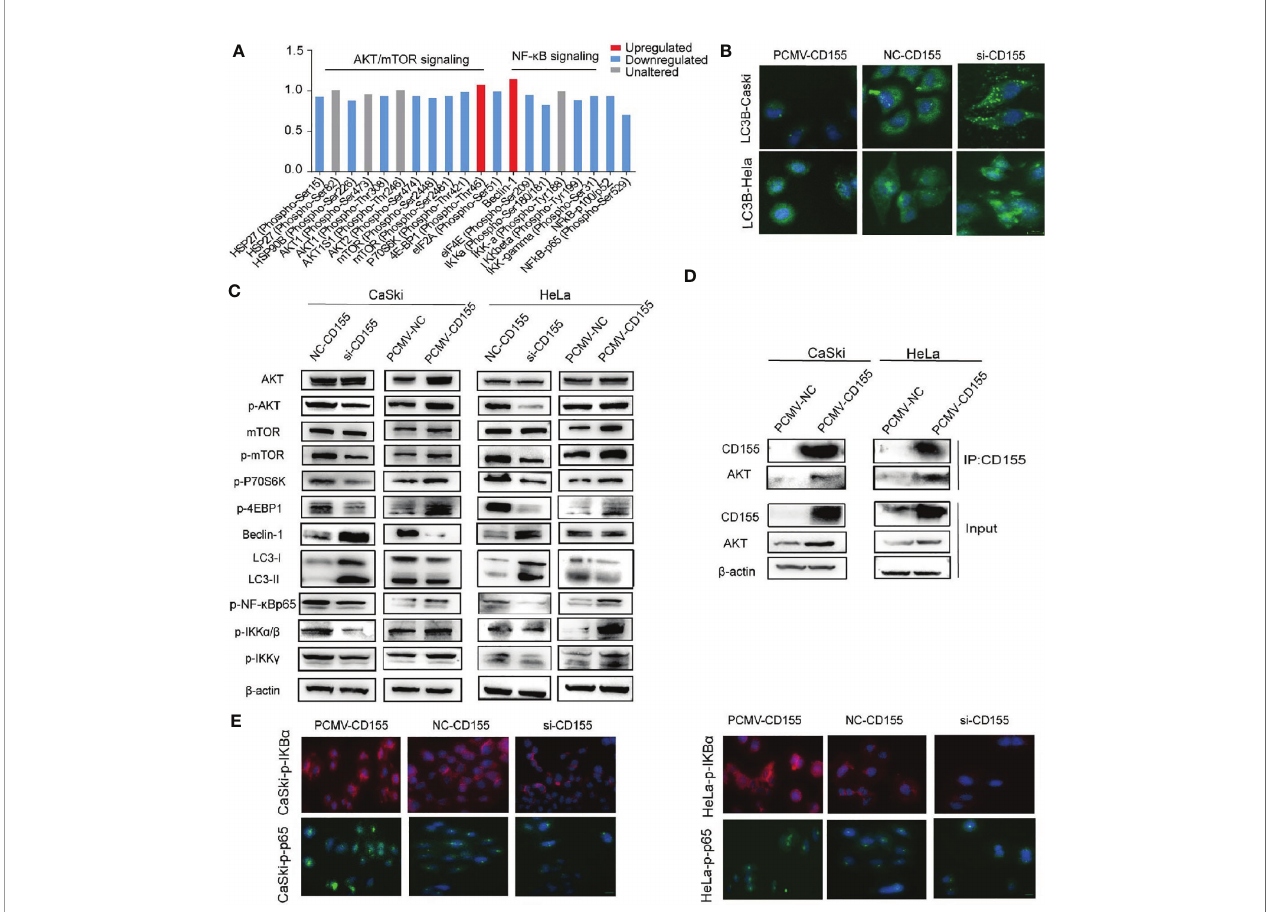
FIGURE 4 | CD155 regulates the AKT/mTOR pathway, autophagy, and the NF- k B (NF- k B) pathway. (A) Phosphoproteome array analysis of phosphoprotein expression changes after CD155 knockdown in CaSki cells. Phosphoproteins whose levels increased or decreased by more than 12% are marked in red and blue, respectively. (B) Immuno fl uorescence staining of LC3B in CaSki and HeLa cells transfected with CD155 siRNA (si-CD155), negative control RNA (NC-CD155), or PCMV-CD155, Scale bar: 10 µm. (C) Western blot analysis of the protein levels of AKT, p-AKT, mTOR, p-mTOR, p-4EBP1, p-p70S6K, Beclin1, LC3I, LC3II, p-NF- k Bp65, p-IKK a / b , and p-IKK g in CaSki and HeLa cells transfected with NC-CD155, si-CD155, PCMV-NC, or PCMV-CD155. b -actin was used as a loading control. (D) The Co-IP results showed that CD155 interacted with AKT to form the CD155/AKT complex. The Co-IP and western blot results showed that in PCMV-CD155 CaSki and PCMV-CD155 HeLa cells, the abundance of the CD155/AKT complex was signi fi cantly increased. (E) Immuno fl uorescence for p-NF- k Bp65, p-IKB a using CaSki and HeLa cells infected with CD155 siRNA (si-CD155), negative control RNA (NC-CD155), or PCMV-CD155, Scale bar: 10 µm. Data are the mean ± SEM of at least three independent